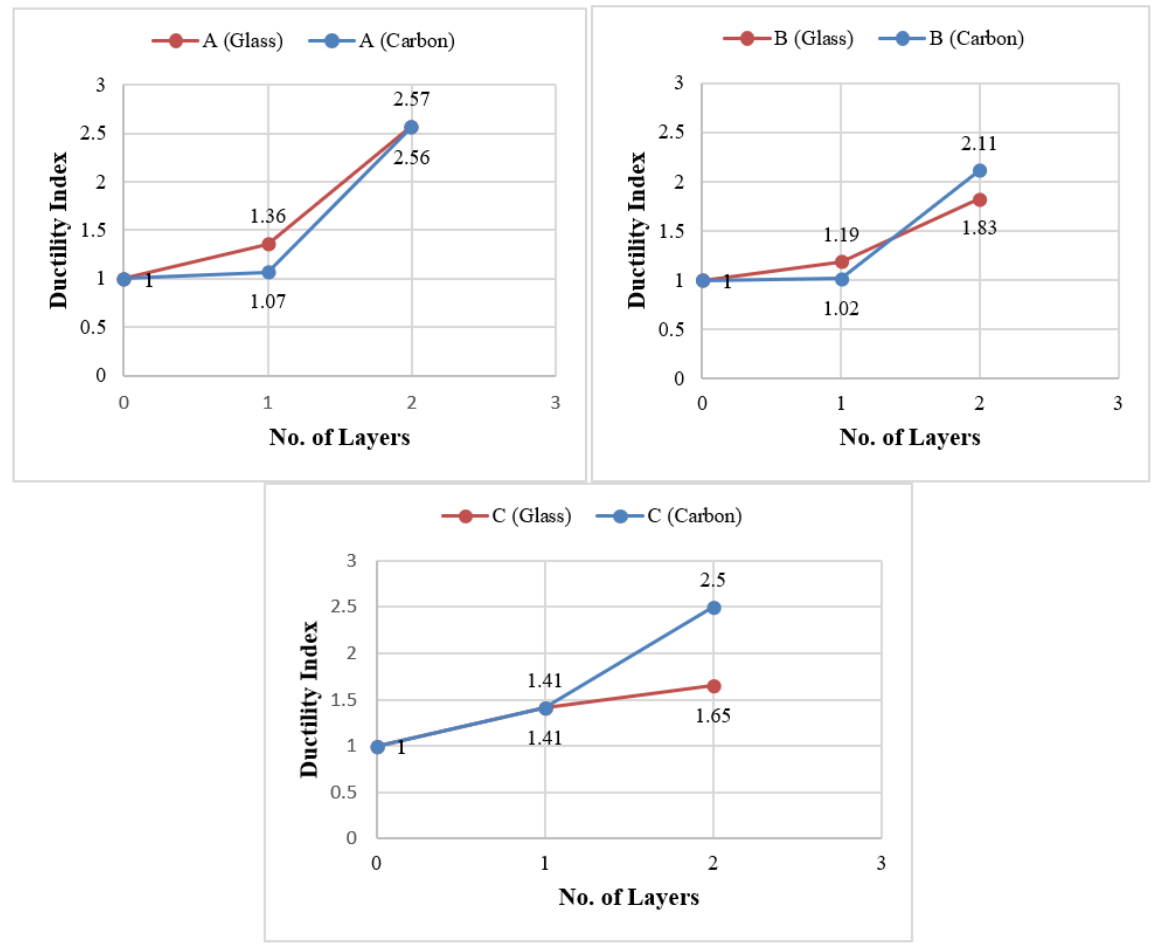
Figure 11: Graphs of ductility indices versus no. of layers for gorups A (4+2 mm), B (3.18+1.4 mm), and C (2+1 mm)